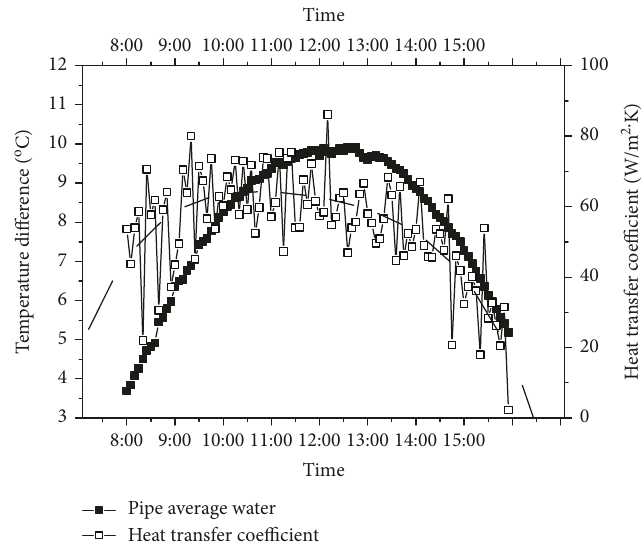
Figure 7: Variations in the heat transfer temperature di ff erence and heat transfer coe ffi cient. Table 4: Experimental results for collector performance linear fi tting.